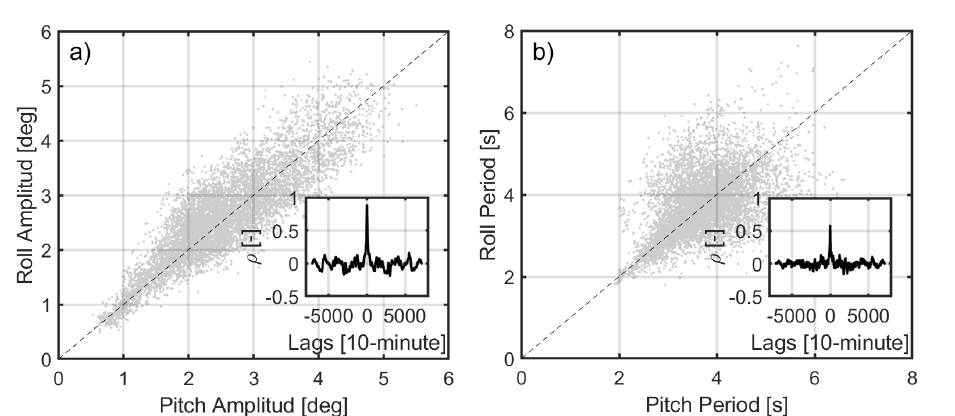
Figure 2. Scatter plots for 10-min-averaged roll and pitch angles. ( a ) angular amplitude; ( b ) angular period. Dashed lines correspond to the 1:1 reference line. Insets show the roll–pitch cross-covariance for different time